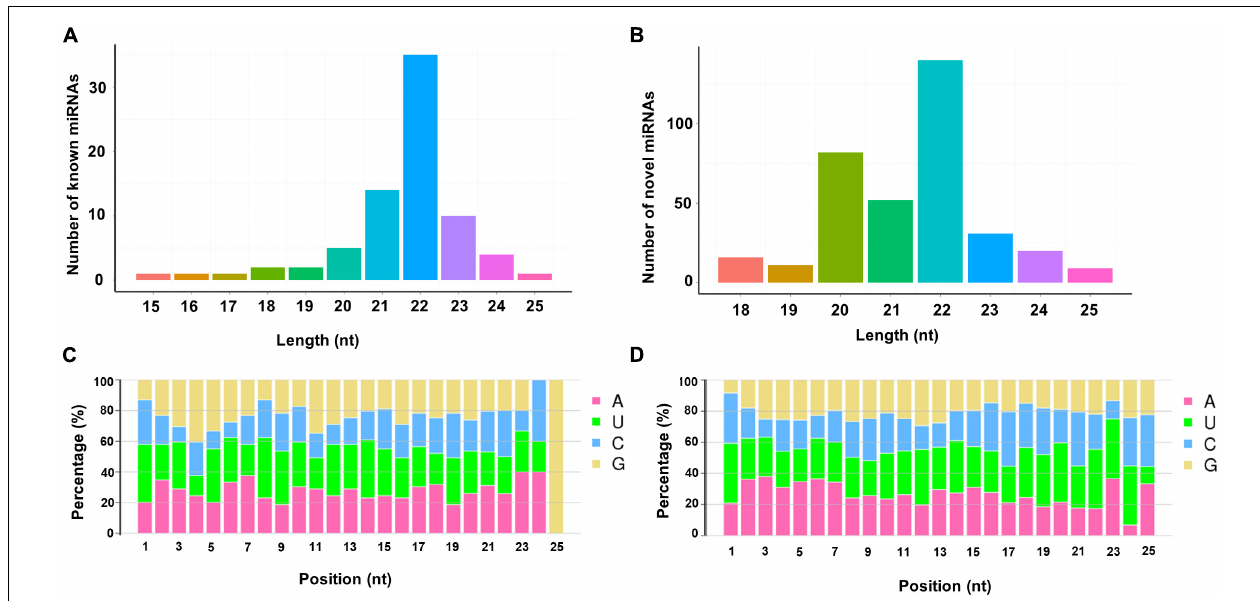
FIGURE 1 | Lengths distribution and nucleotide bias of miRNAs identified in the sRNA libraries. (A) Lengths distribution of known miRNAs; (B) lengths distribution of novel miRNAs; (C) nucleotide bias of known miRNAs; (D) nucleotide bias of novel